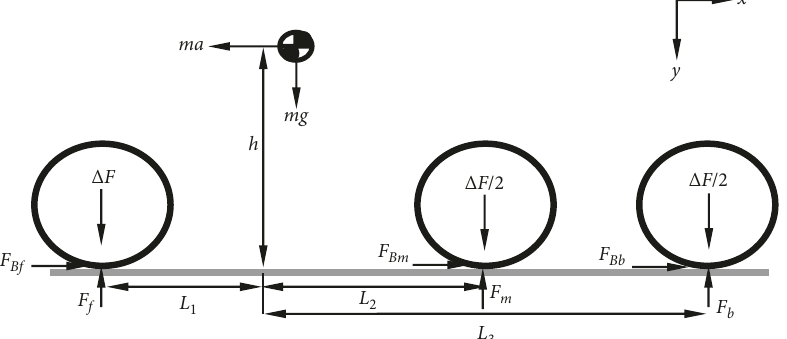
Figure 4: Right front wheel braking force distribution diagram.